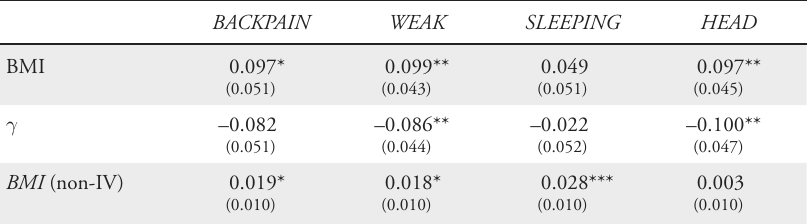
Table 4: Logit Regression of BMI on Reported Health Issues BACKPAIN WEAK